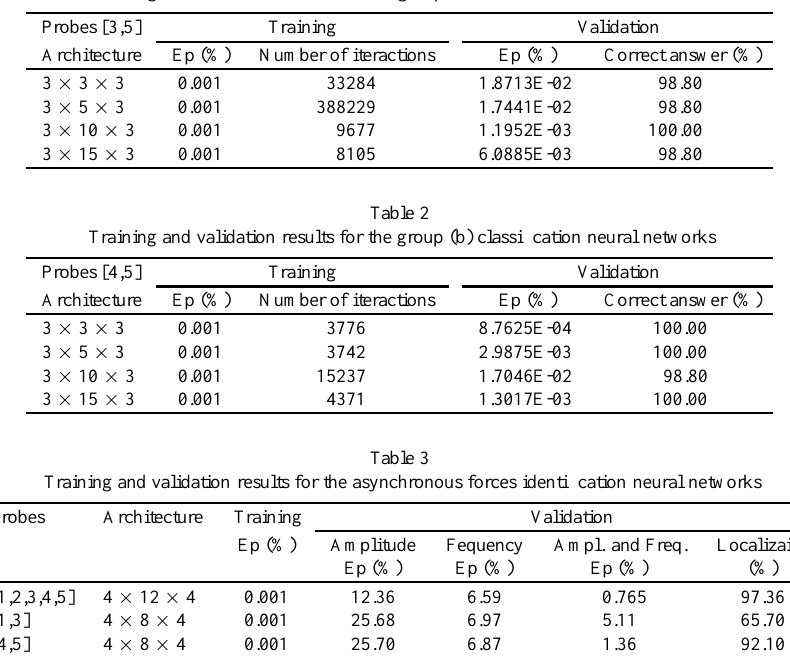
Table 1 Training and validation results for the group (a) classification neural networks